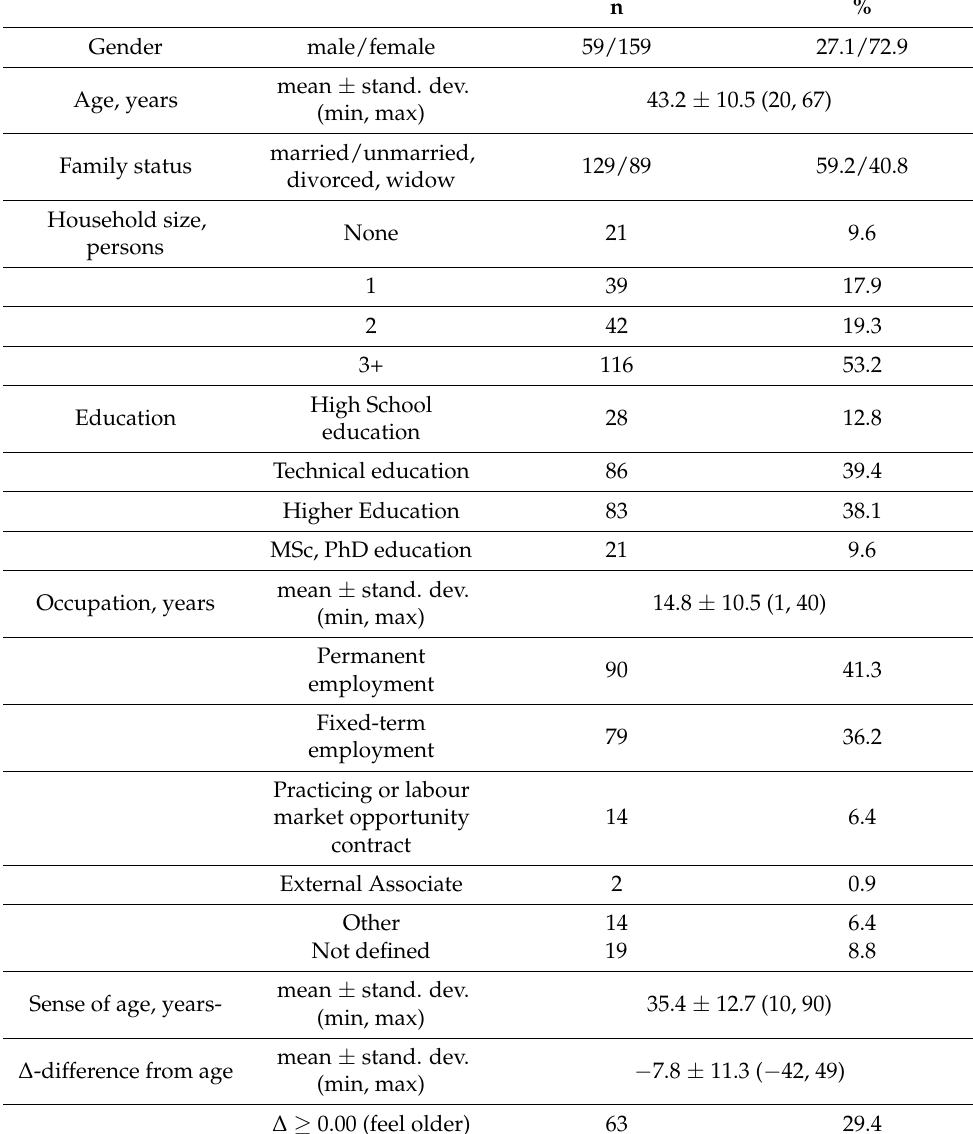
Table 1. Basic descriptive characteristics of 218 study